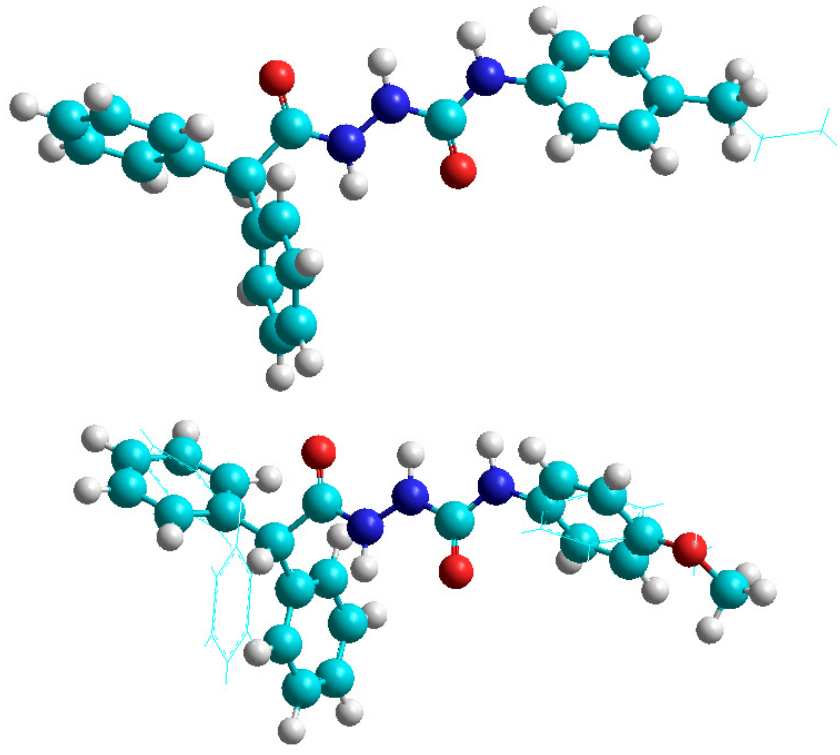
Figure 7. Overlay of structures of 1a (balls and sticks) and 3a (sticks) ( top ) and 1a (sticks) and 2a (balls and sticks) ( bottom ).